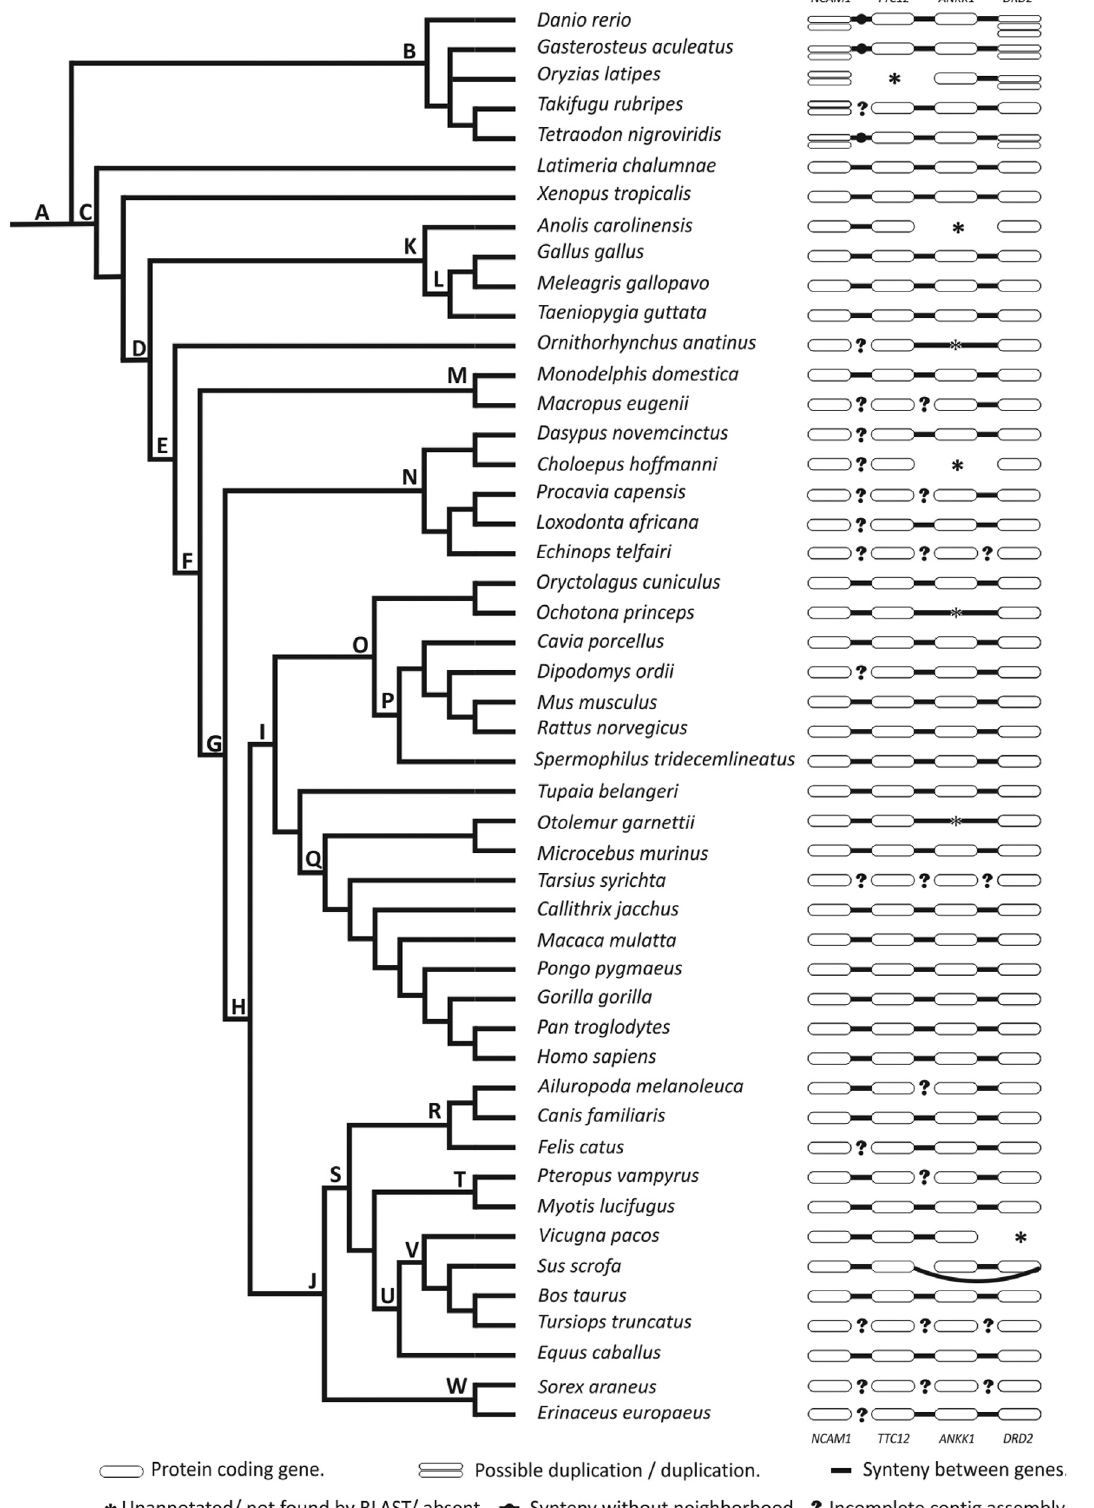
Figure 1 - Conservation of synteny and neighborhood in the NTAD cluster across 48 vertebrate genomes. The tree was compiled based on Agnarsson et al. 2010, Asher and Helgen 2010, Horner et al. 2007, Janes et al. 2010, Page and Goodman 2001, Pacheco et al. 2011. A : Vertebrata; B : Teleostei; C : Sarcopterygii; D : Amniota; E : Mammalia; F : Theria; G : Eutheria; H : Boreoeutheria; I : Euarchontoglires; J : Laurasiatheria; K : Sauria; L : Aves; M : Marsupialia; N : Atlantogenata; O : Glires; P : Rodentia; Q : Primates; R : Carnivora; S : Scrotifera; T : Chiroptera; U : Euungulata; V : Artiodactyla; W :